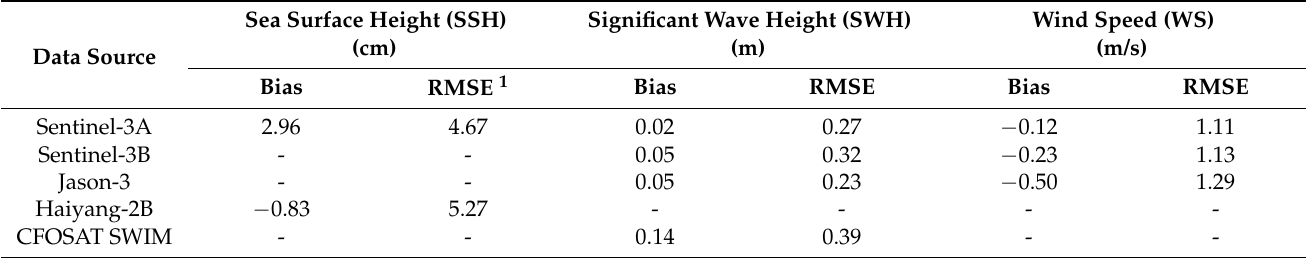
Table 3. Error statistics of new remote sensing data